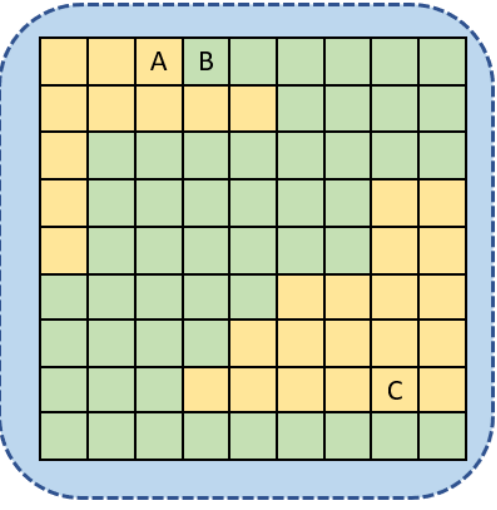
Figure 4. The ground distribution of an HSI is very complex. Pixel A and pixel B are very close in spatial location, but the categories are different. Pixel A and pixel C are far from each other but have the same